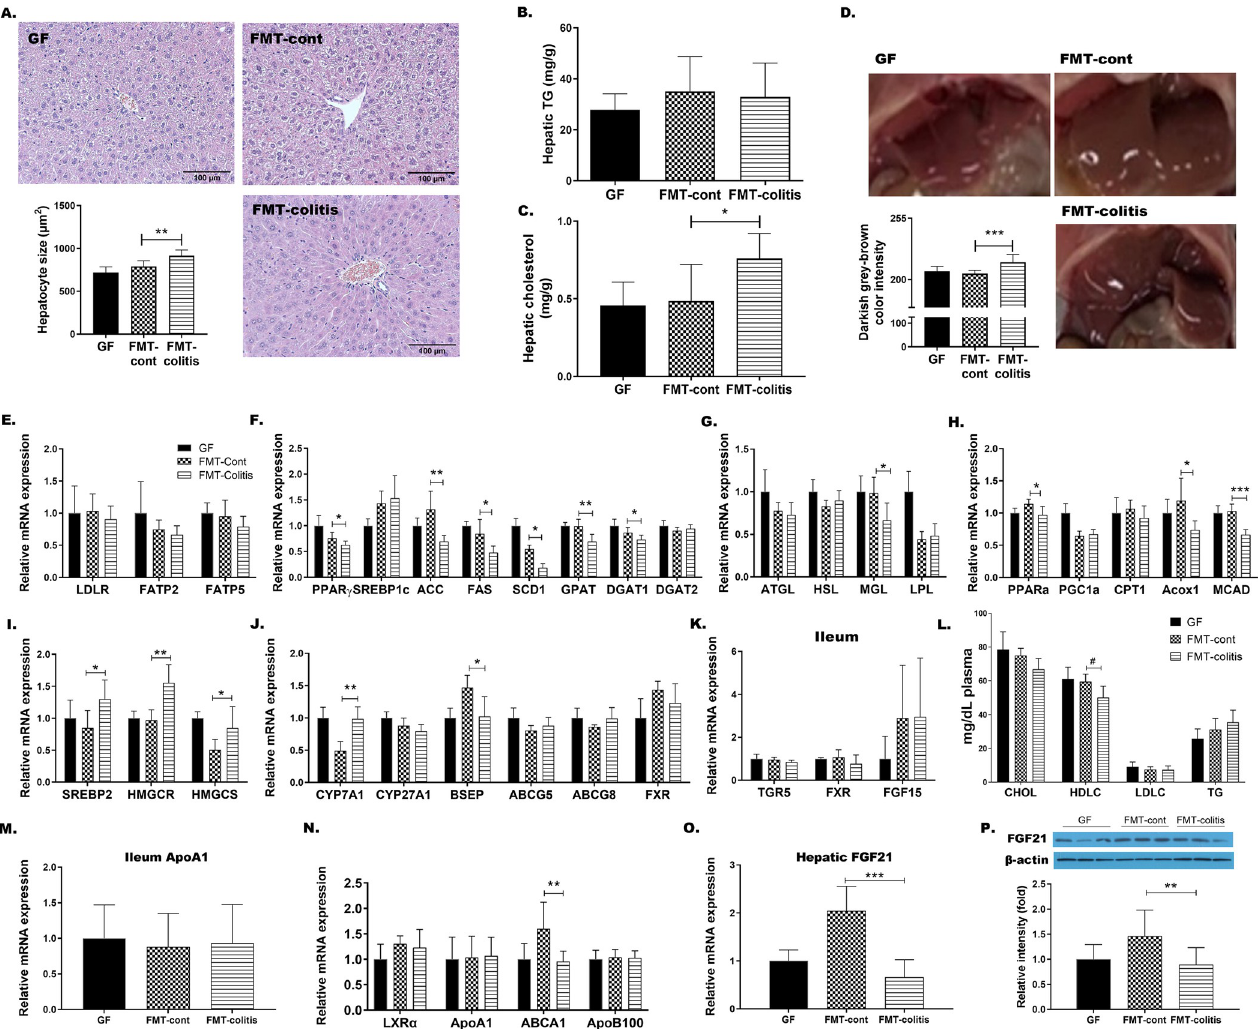
Fig 3. Transplantation of fecal microbiota from colitis mice disrupted hepatic lipid metabolism in recipient GF mice. (A) Representative images of H&E stained liver sections (left, x200) and a graph presenting the size of hepatocytes. (B-C) Hepatic TG and cholesterol content. (D) Representative images of the liver and a graph presenting the darkish grey-brown color intensity scaled from 0 (bright red-brown) to 255 (darkish grey-brown). The hepatic mRNA expression of genes related to (E) fatty acid uptake, (F) de novo lipogenesis, (G) lipolysis, (H) fatty acid oxidation, (I) cholesterol synthesis, and (J) the synthesis and excretion of bile acids. (K) The gene expression of TGR5, FXR, and FGF15 in distal ileum. (L) The plasma levels of cholesterol (CHOL), HDL-cholesterol (HDLC), LDL-cholesterol (LDLC), and triglyceride (TG). In L, statistical significance was determined by ordinary one-way ANOVA with Dunnett’s multiple comparison test ( # p < 0.033, ## p < 0.002, and ### p < 0.001). (M) The gene expression of ApoA1 in distal ileum. (N) The expression of ApoB100 and genes related to reverse cholesterol transport. (O) Hepatic FGF21 gene expression and (P) plasma FGF21 levels. Data are presented as the mean ± SD of each group (n = 5–7). Statistically significant difference between FMT-control and FMT-colitis group was determined by Student’s two-tailed t-test ( � p < 0.05, �� p < 0.01, and ��� p <